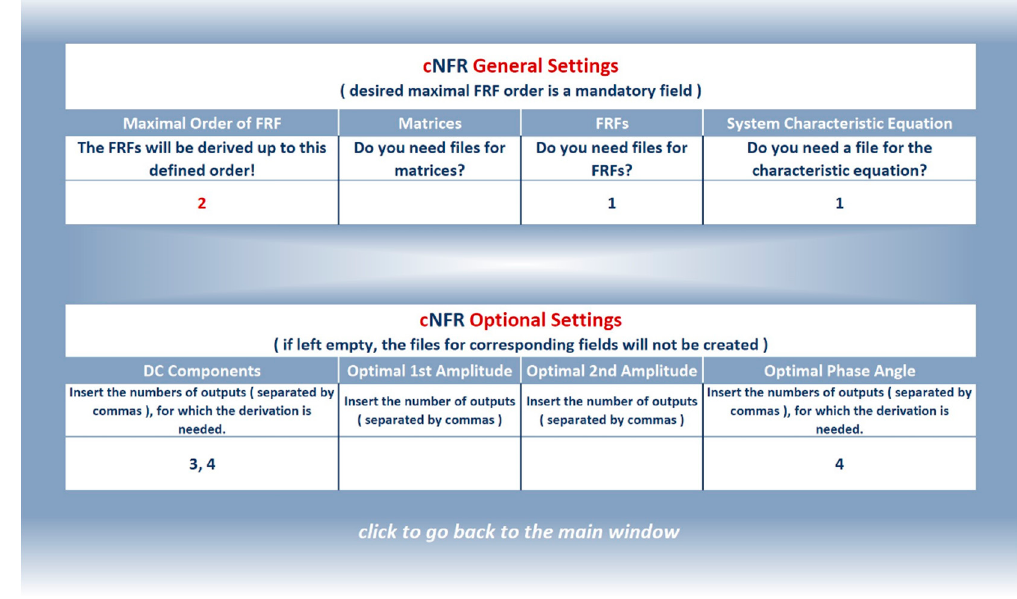
Figure 9. cNFR Settings Window for Example 1: CSTR.